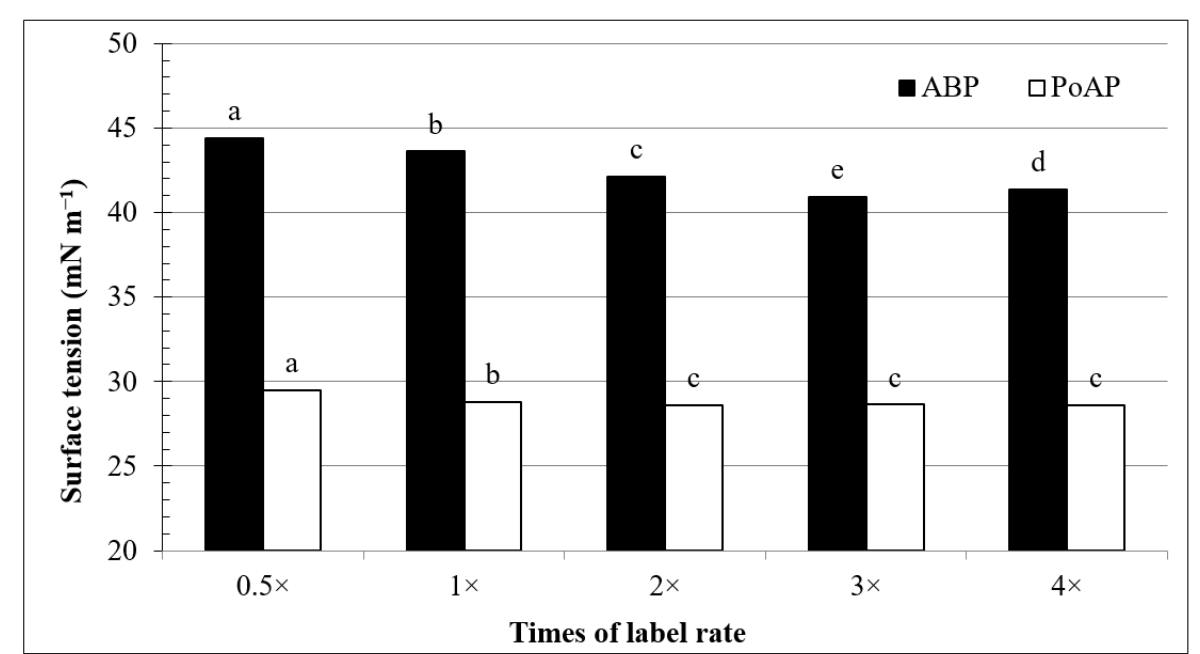
Figure 2. Surface tension of alkyl block polymer (ABP) and polyoxyalkylene polymer (PoAP) influenced by their concentrations at 0.5×, 1×, 2×, 3×, and 4× label suggested rates, which corresponded to 12.5, 25.0, 50.0, 75.0, and 100.0 mL L −1 for ABP, and 14.4, 28.8, 57.6, 86.4, and 115.2 mL L −1 for PoAP, respectively. Bars labeled by the same letter for each wetting agent are not significantly different based on Fisher’s Protected LSD at p < 0.05.